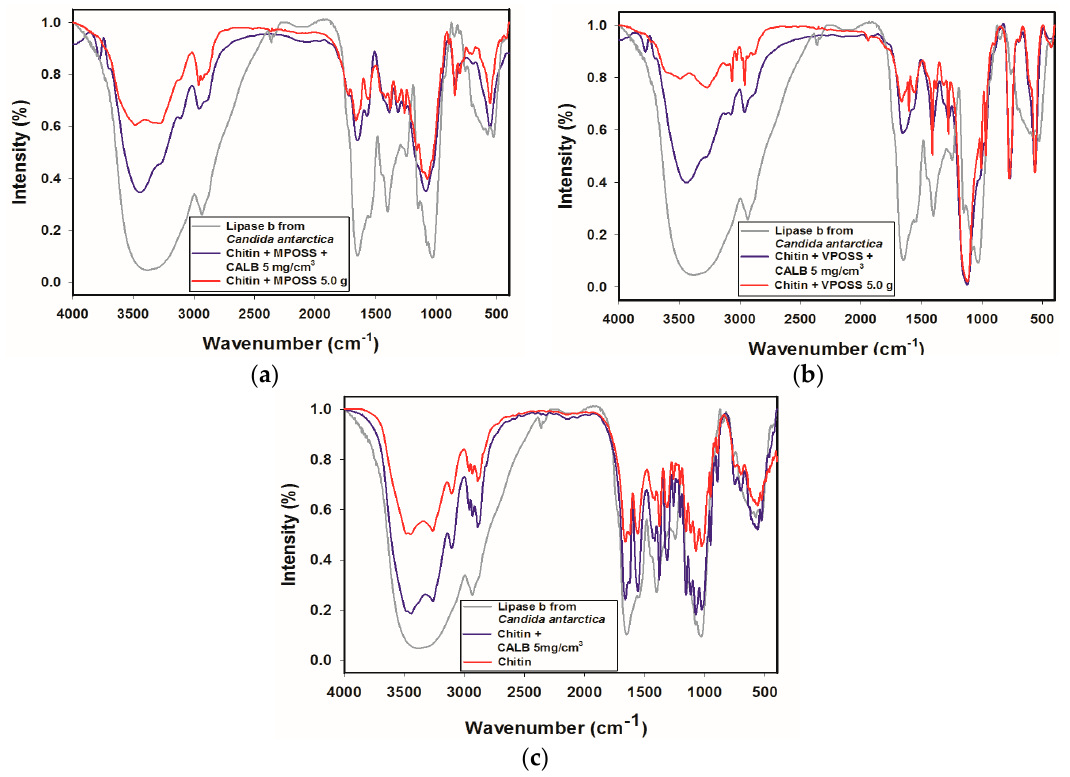
Figure 4. Results of FTIR analysis of the native lipase B from Candida antarctica (CALB), chitin, chitin-POSS hybrid materials, and products after enzyme immobilization: ( a ) chitin + MPOSS + CALB; ( b ) chitin + VPOSS + CALB; and ( c ) chitin + CALB.